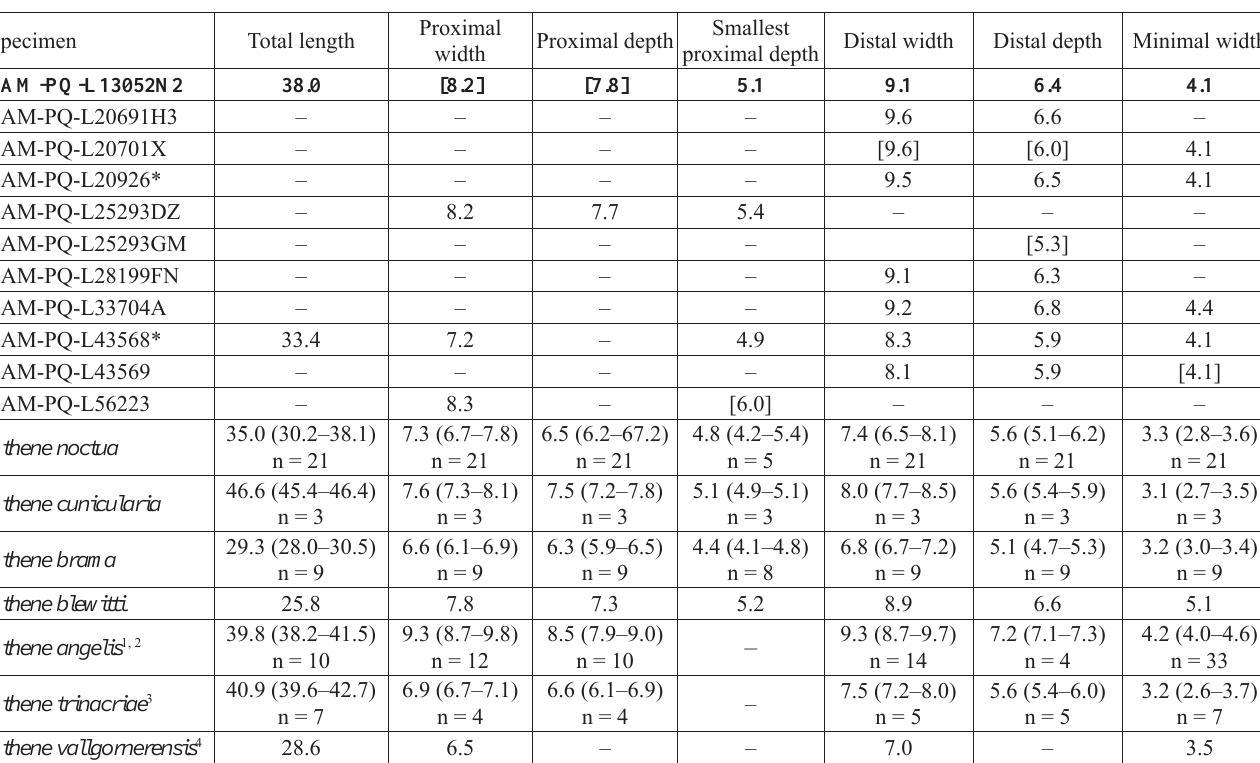
Table 7. Measurements (in mm) of the tarsometatarsus of Athene inexpectata sp. nov. from Langebaanweg compared with the corresponding bones of various living and fossil Athene species. Measurements of slightly worn or damaged bones are given in square brackets. The holotype is highlighted in bold, paratypes are indicated by an asterisk. 1 measurements after Mourer-Chauviré et al. (1997); 2 measurements after Louchart (2002); 3 measurements after Pavia and Mourer-Chauviré (2002); 4 measurements after Guerra et al. (2012); n, sample size.